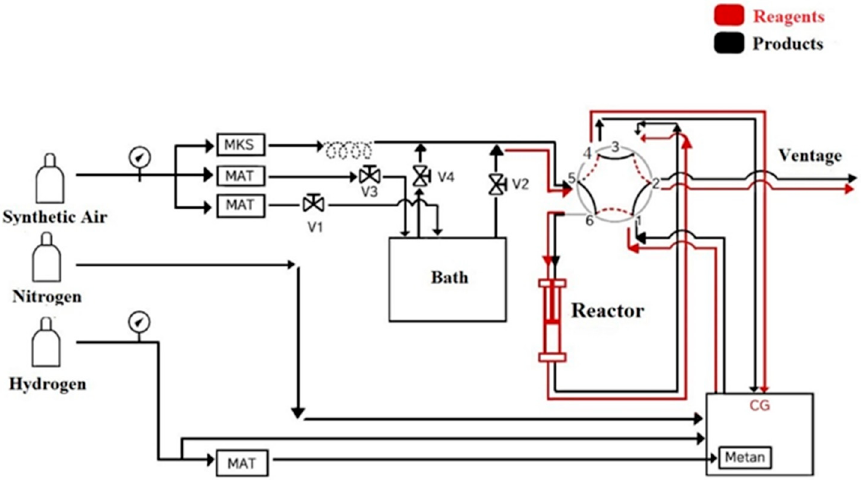
Figure 15. Schematic diagram of the catalytic activity test system.